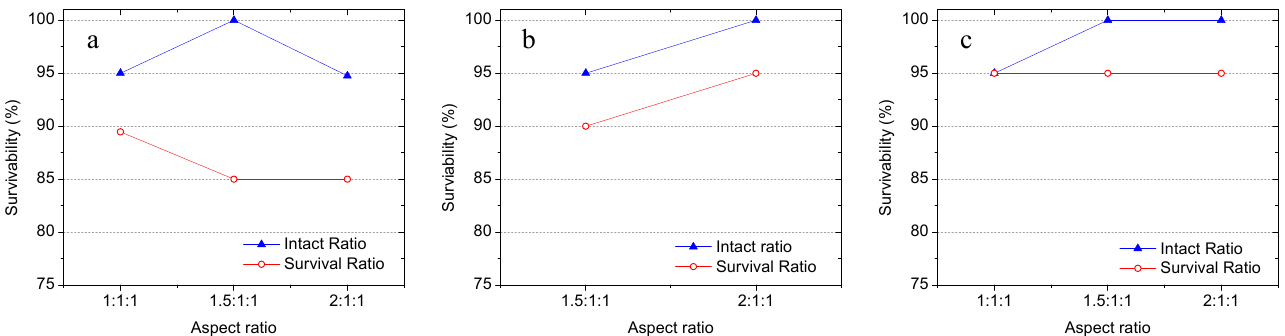
Figure 6. Influence of aspect ratio on the survivability of capsules with ( a ) a minor diameter of 19.05 mm and thickness of 0.8 mm, ( b ) minor diameter of 9.5 mm and thickness of 0.8 mm, and ( c ) minor diameter of 9.5 mm and thickness of 0.4 mm.